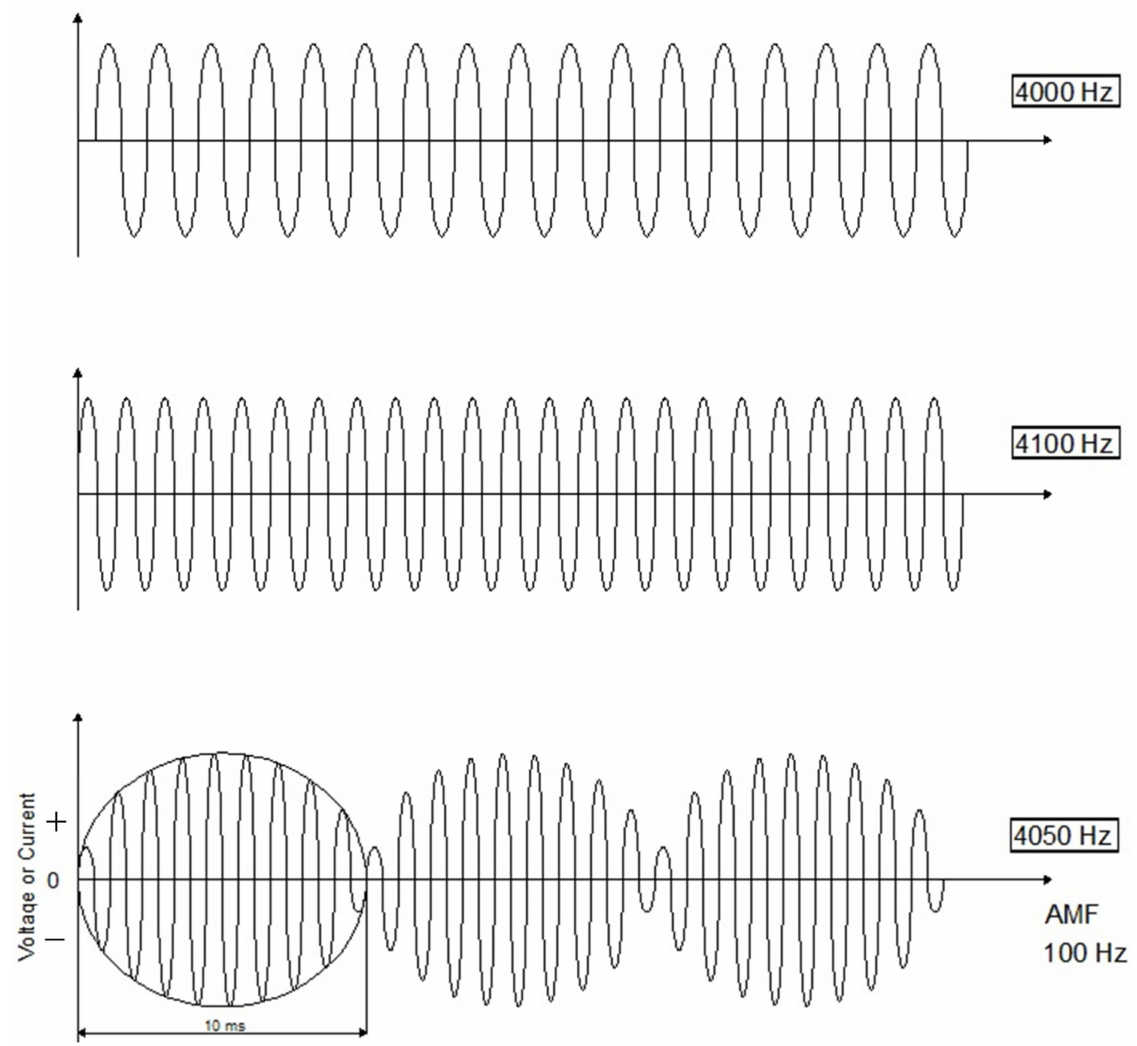
Figure 1. The two out-of-phase medium-frequency alternating currents (4000 Hz and 4100 Hz) “interfere” within the tissues and produce an amplitude-modulated frequency (AMF) of 100 Hz. The resulting frequency is 4050 Hz, and the duration of each burst is 10 milliseconds (ms). Hz: